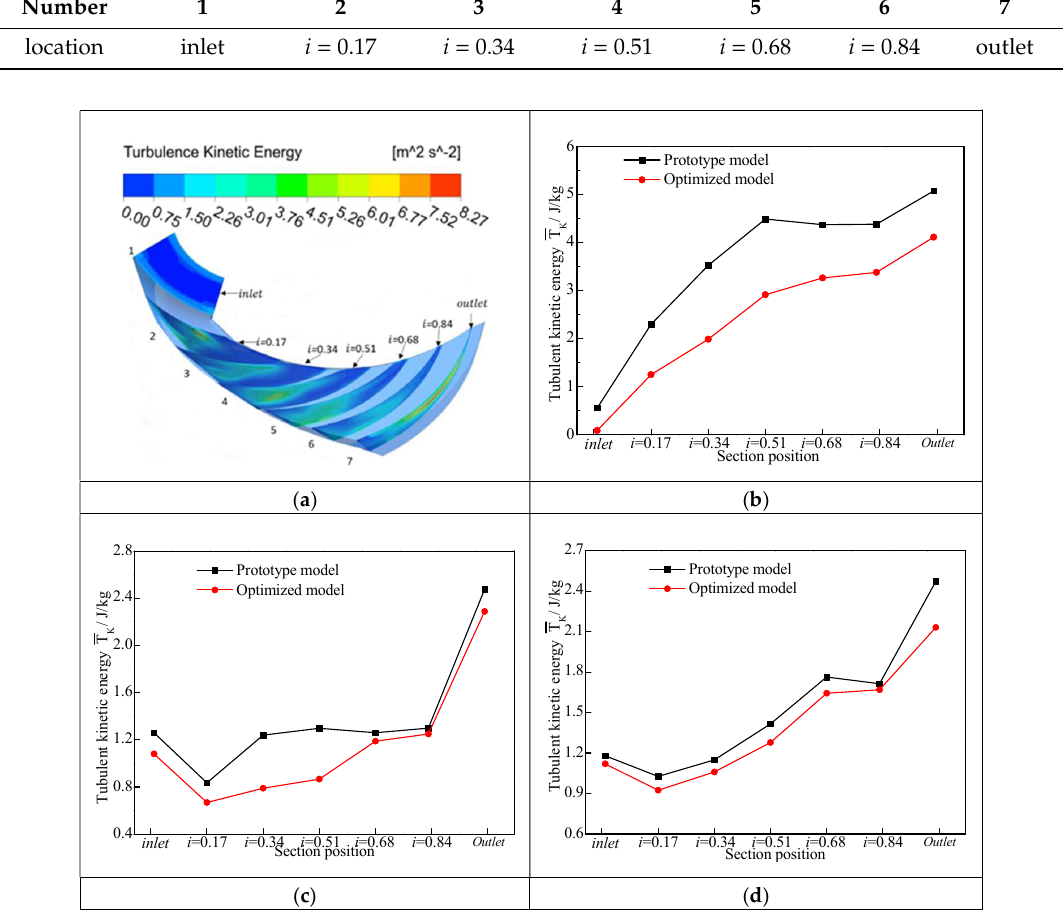
Figure 14. Distribution of average turbulent kinetic energy at 10% inlet gas volume fraction. ( a ) Cross section position; ( b ) First stage; ( c ) Second stage; ( d ) Third stage.